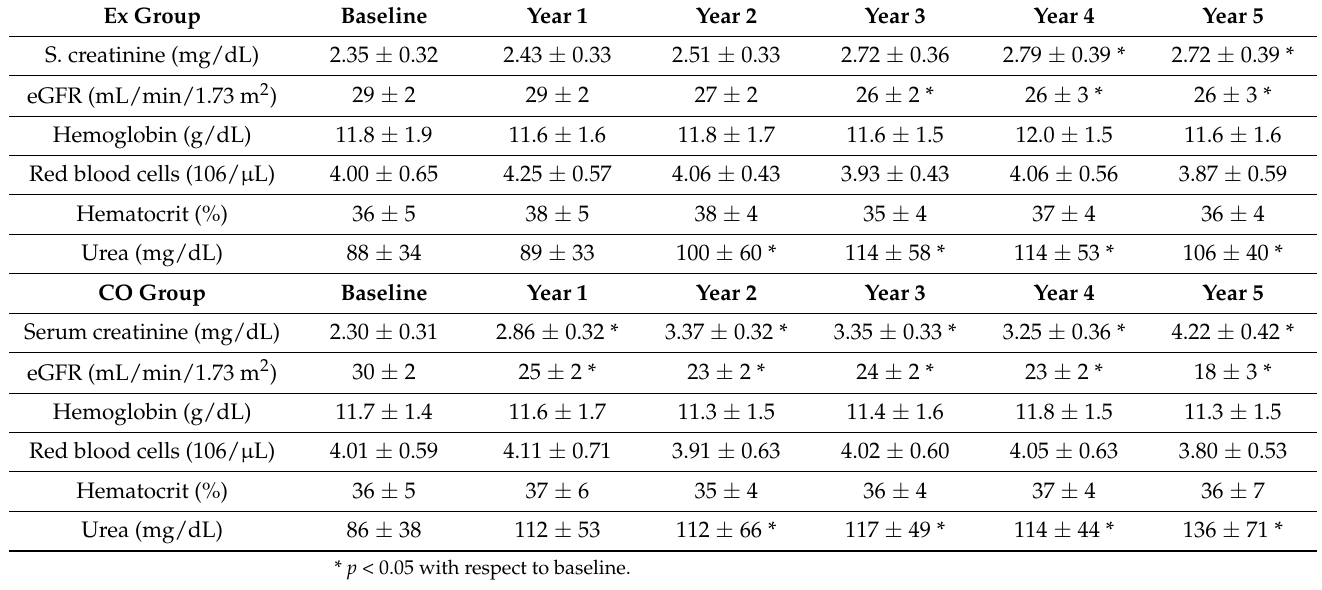
Table 2. Variations in laboratory parameters over time in both groups.